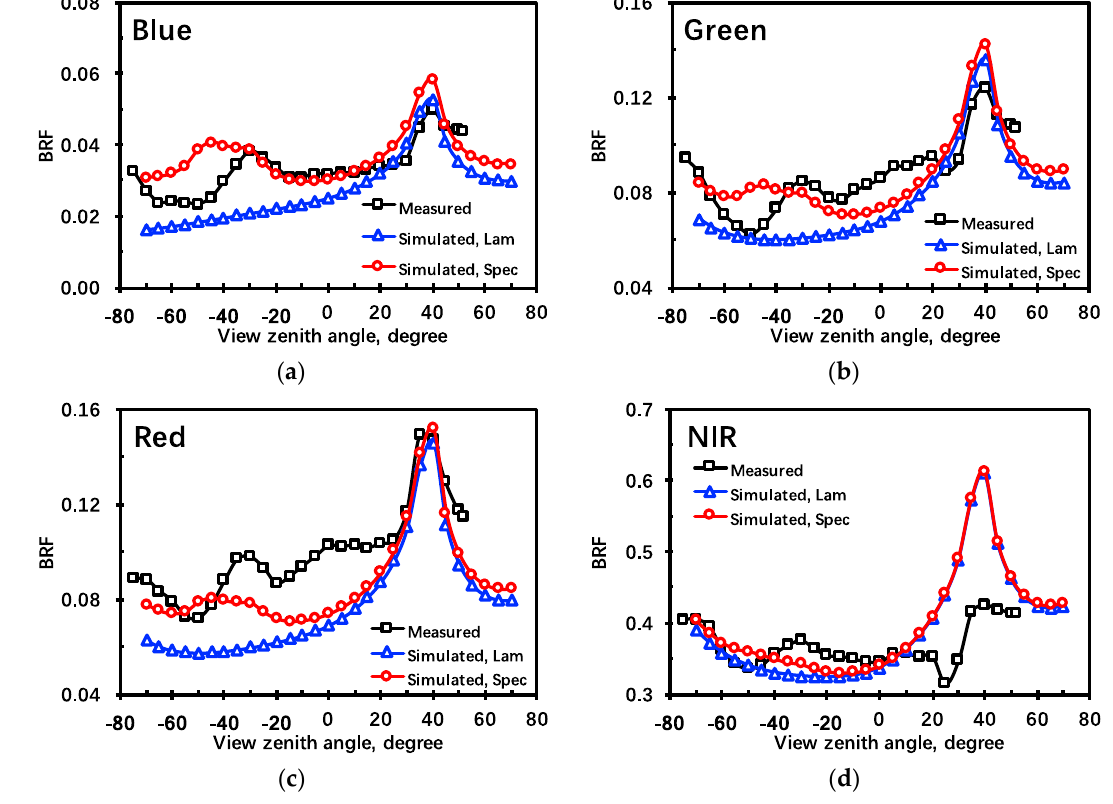
Figure 2. Comparison between field-measured and modeled maize BRF at blue ( a ), green ( b ), red ( c ) and NIR ( d ) bands. Legend “Simulated, Lam” represents the modeled BRF with bi-Lambertian leaves, i.e., leaf specular reflection is neglected. Legend “Simulated, Spec” denotes that accounting for leaf specular reflection. Legend “measured” means field-measured maize BRF .